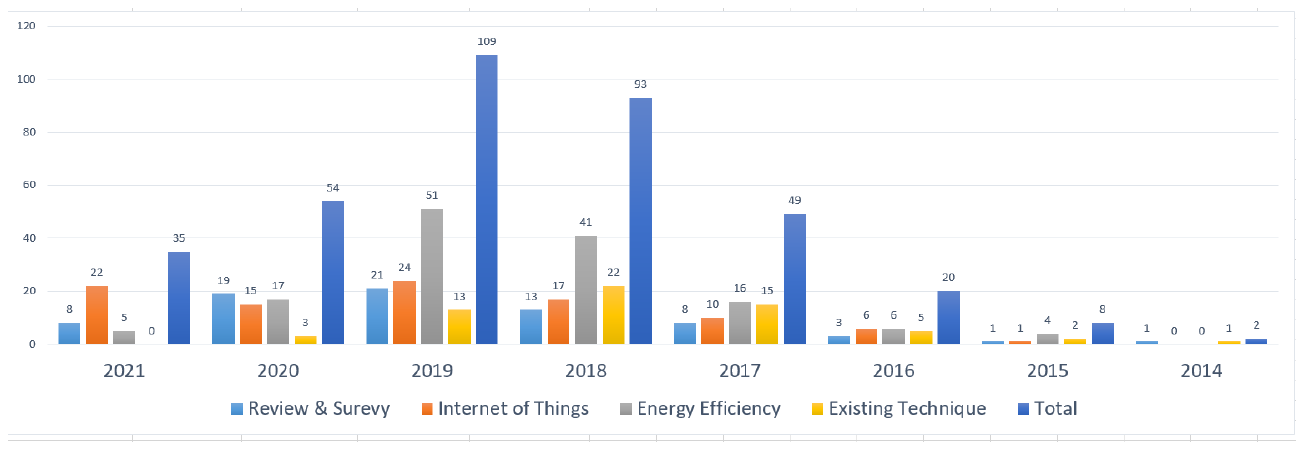
Figure 4. Published articles in between 2014 and 2021.